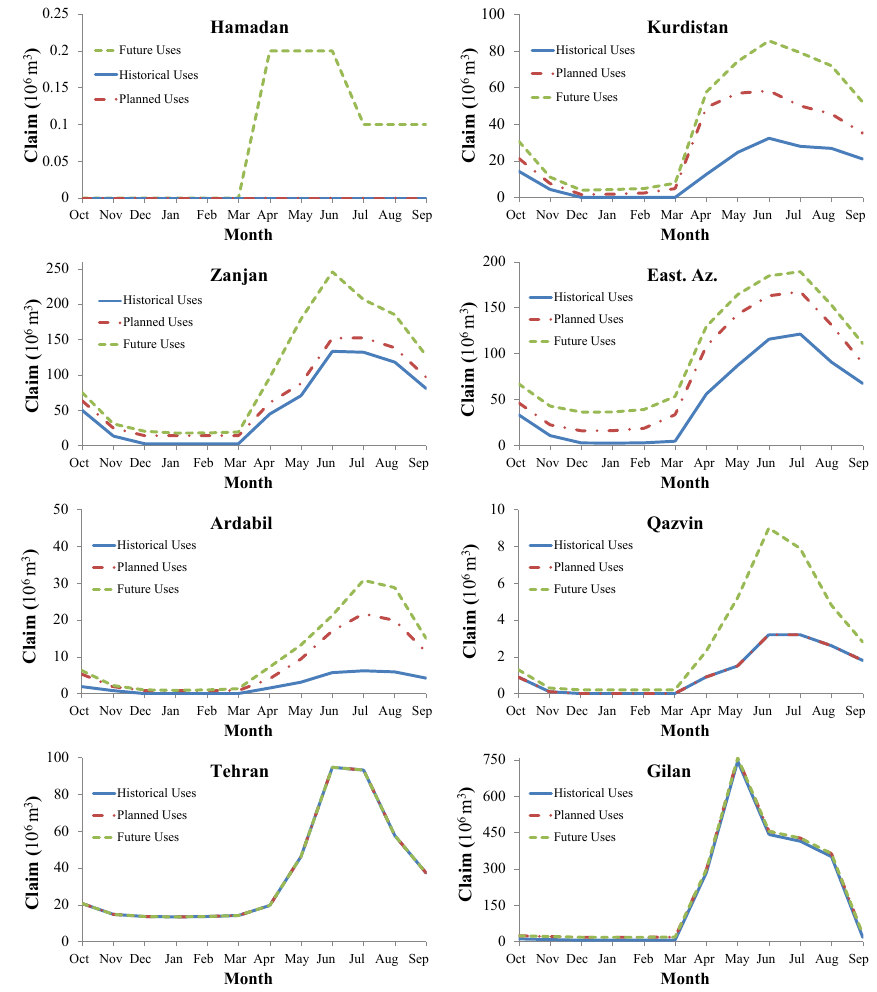
Figure 3. Estimated monthly claims of the riparian provinces based on the three proposed claim calculation method